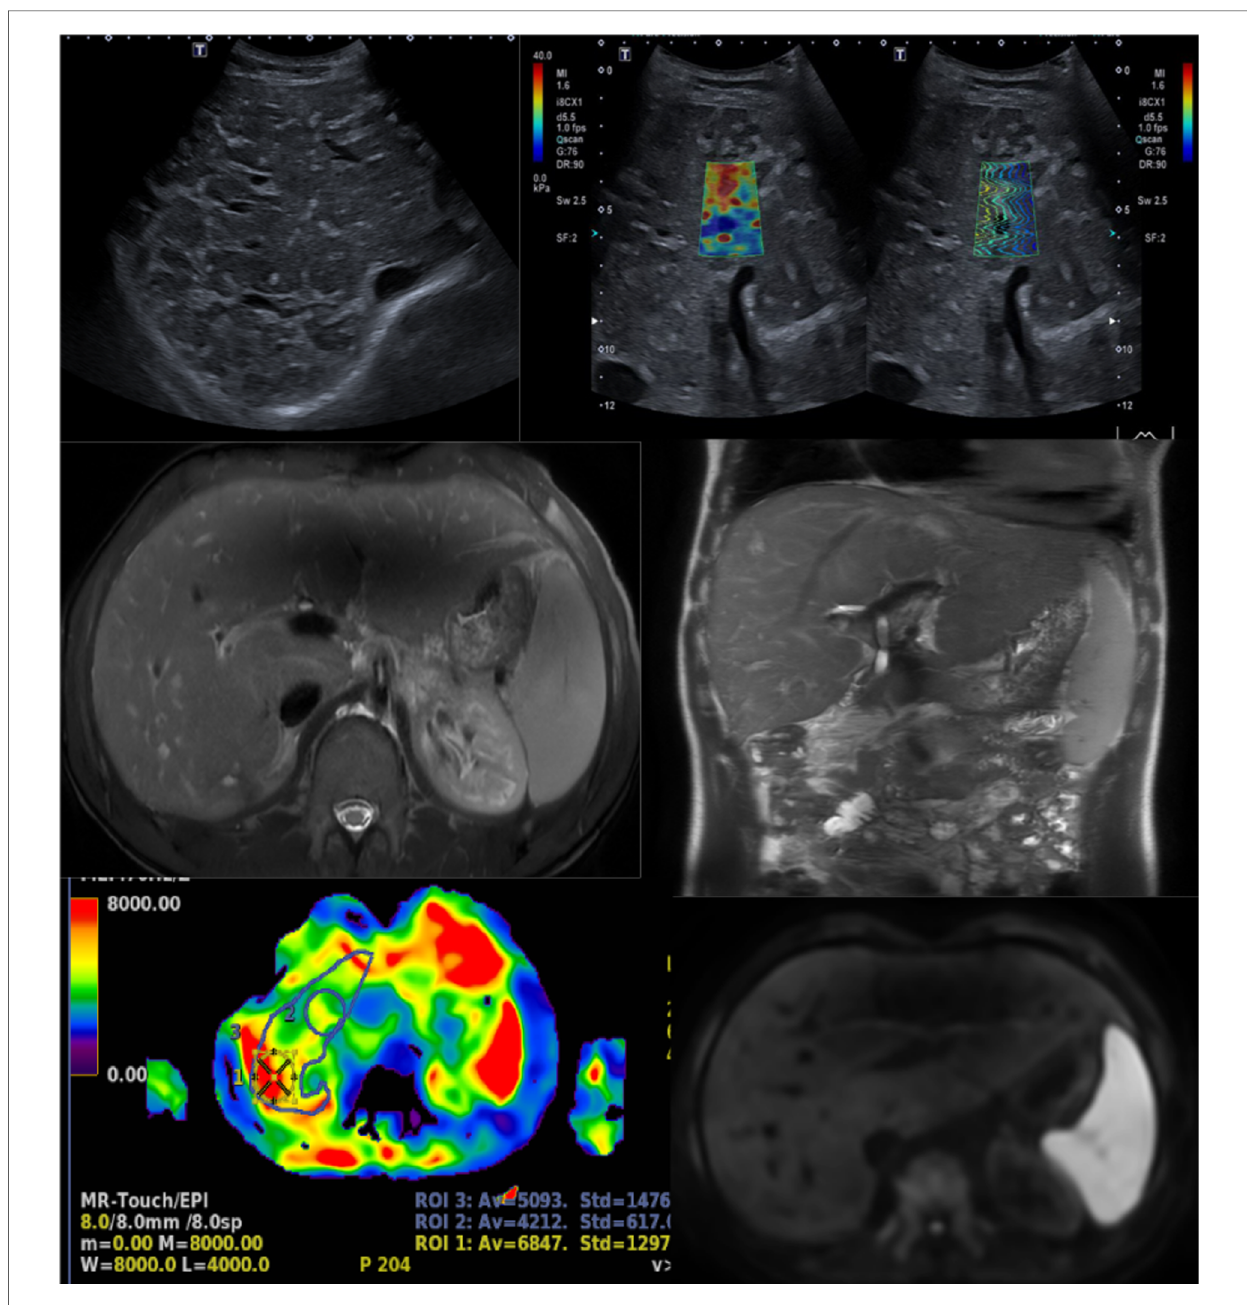
FIGURE 6 A 17-year-old boy with a hypoplastic left heart complex and Fontan circulation (same patient as in Figure 5 ). Clinical workup revealed a slightly increased GGT and a newly developed reduced exercise capacity. Ultrasound reveals severe heterogeneous echogenicity (upper left) and increased values of elasticity of 25 kPa (upper right). Abdominal MR T2-weighted coronal image (middle right), with increased size right liver lobe. The liver length is 20 cm and there is a splenomegaly measuring 17 cm in length. Corresponding axial T2-weighted image reveals the reticular peripheral pattern (middle left). Heterogenous diffusion (lower right). MR elastography in an axial plane, measuring increased values of 5.1 KPa (lower left). GGT, gamma- glutamyl